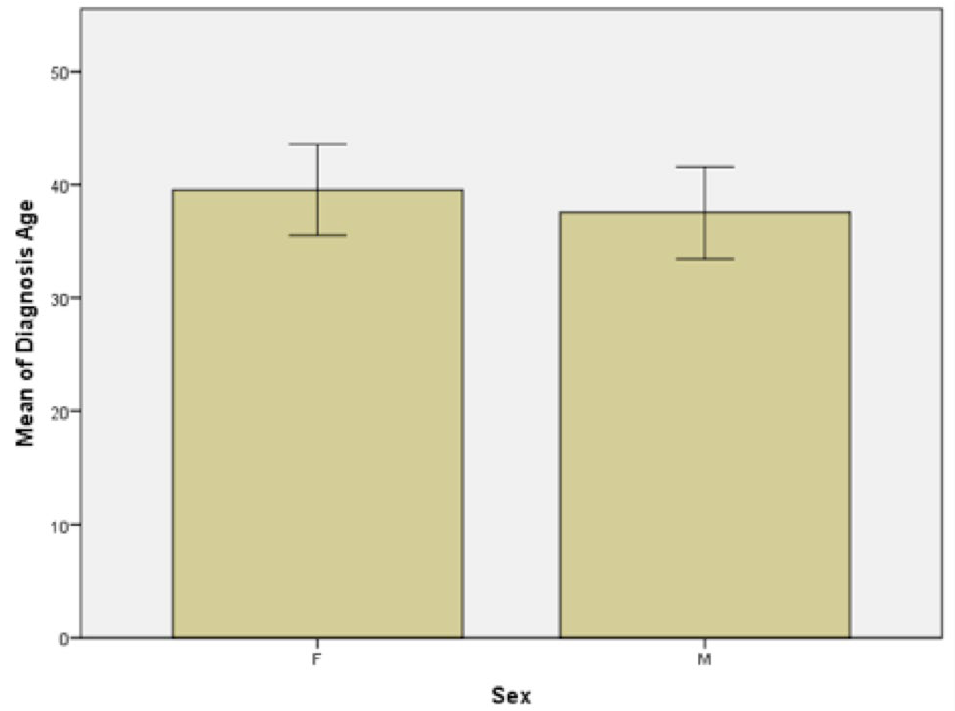
Figure 3. Age at psoriasis diagnosis in females (F) and males (M) subgroups. Secondly, the mean age in women subgroup at which patients started smoking is 24.08 years, with a median of 21.5 years compared to the mean age in the men subgroup, which is 19.61 with a median of 18 years (Figure 4). This means that the onset of smoking is earlier in male population and the difference is statistically significant with a p value of 0.02 ( p < 0.05).